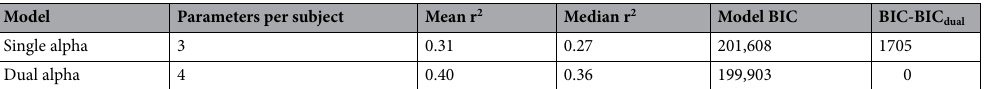
Table 1. Model comparison for within-subject data set. BIC measures are summed across the within- subject dataset (N = 2599). Both models included choice stochasticity (inverse temperature) and loss aversion parameters. The final column is the difference between the model BIC and BIC for the Dual Alpha